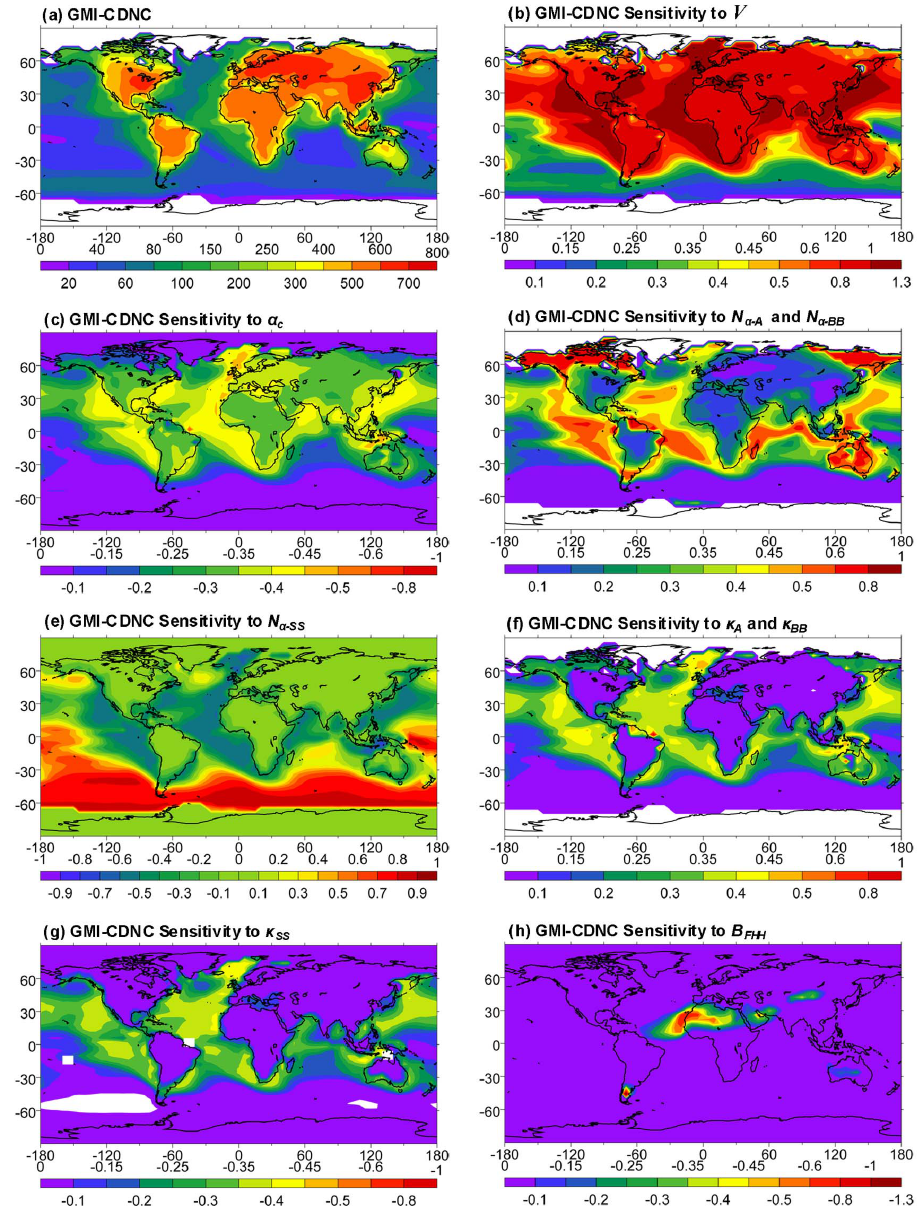
Fig. 3. Predicted annual mean (a) cloud droplet number concentration (cm − 3 ), and its sensitivity to (b) updraft velocity ( V ), (c) uptake coefficient ( α c ), (d) anthropogenic and biomass burning aerosol number concentration ( N α − A + N α − BB ), (e) sea salt aerosol number con- centration ( N p − SS ), (f) anthropogenic and biomass burning aerosol hygroscopicity ( κ A + κ BB ), (g) sea salt aerosol hygroscopicity ( κ SS ) and (h) B FHH adsorption parameter derived from the aerosol concentration fields of GMI model for the lowest cloud-forming